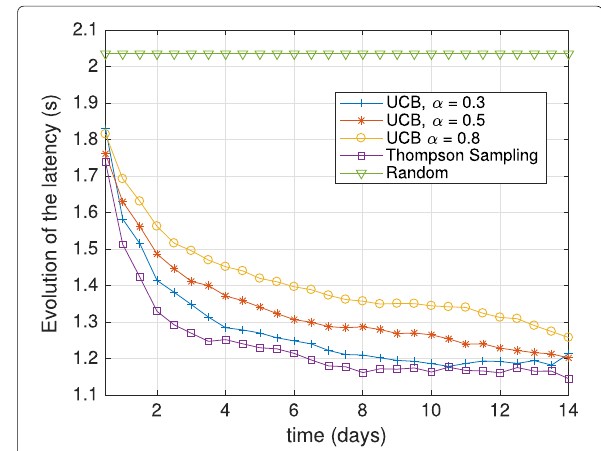
Fig. 14 Evolution of latency with time for different learning